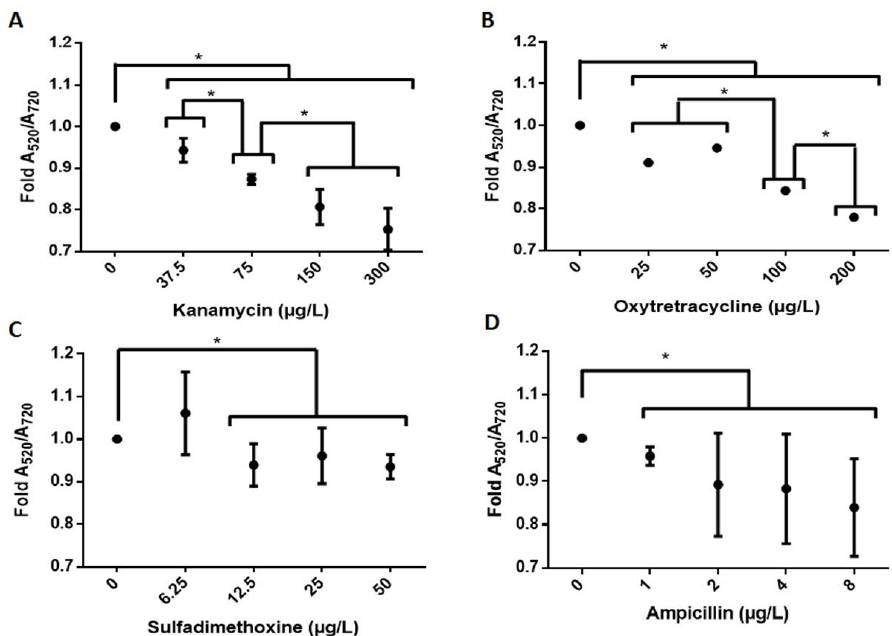
Figure 5. Colorimetric detection of the antibiotics in water for ( A ) kanamycin, ( B ) oxytetracycline, ( C ) sulfadimethoxine and ( D ) ampicillin, based on the A 520 /A 720 absorption ratio. Results were averaged from three independent experiments ( n = 3). Data were analyzed using a nonparametric Mann–Whitney U test. Asterisks denote statistically significant differences between the treatments and controls. * = p <